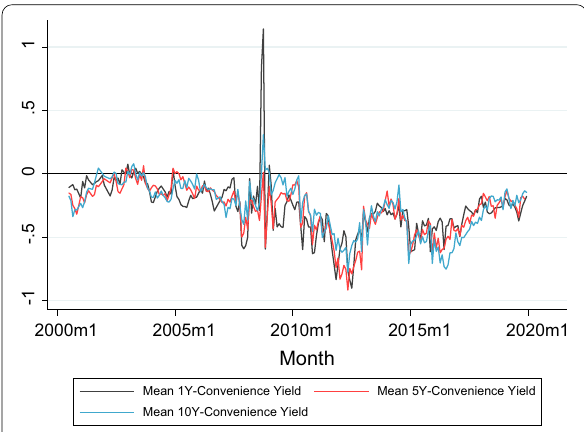
Fig. 6 Convenience Yield ‑ Swiss Franc. This figure shows the average convenience yields (expressed in percentage points), defined in